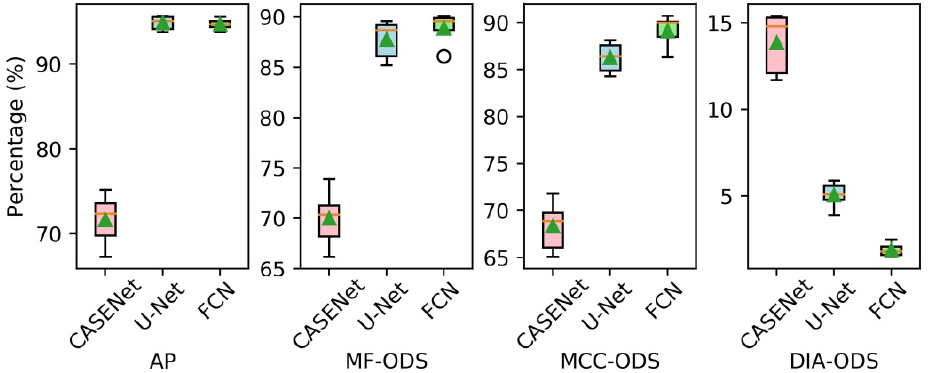
Figure 15. The performances of different methods. Table 5. The mean values of evaluation metrics computed from different methods.